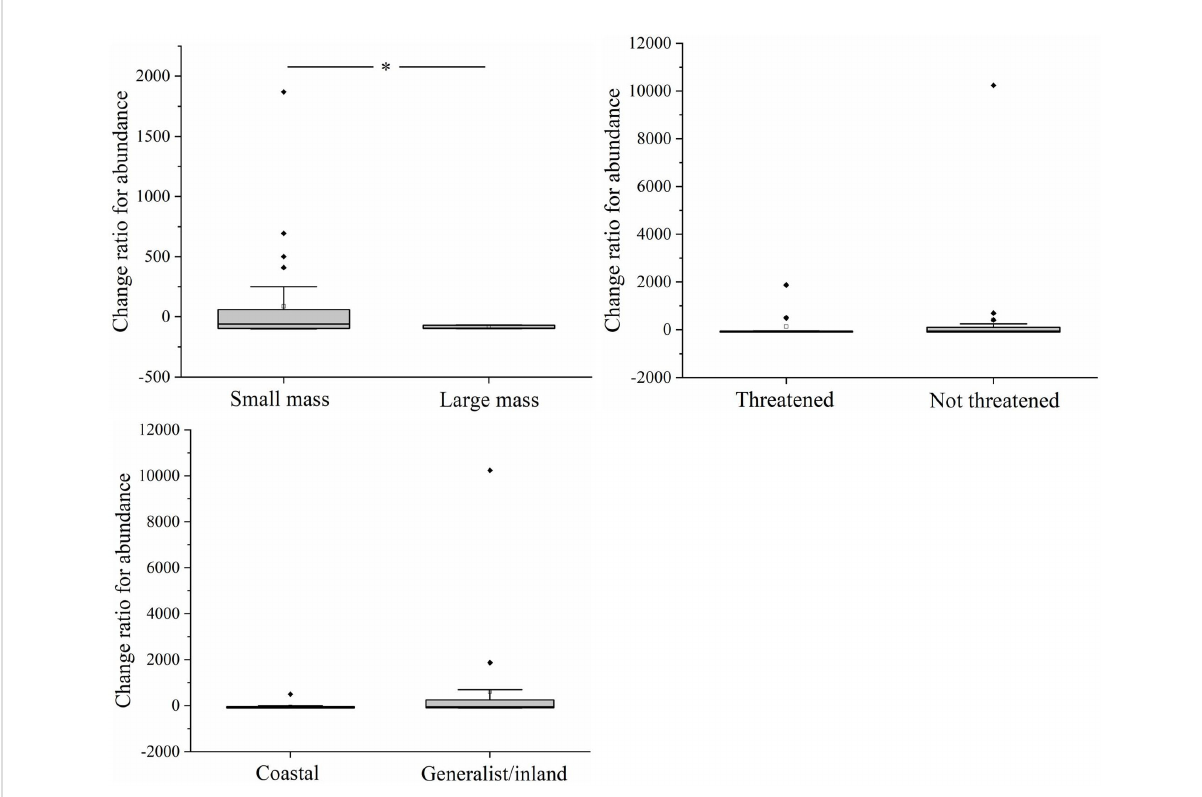
FIGURE 5 Differences in changes in the abundance of each species between functional groups in the Yellow River Delta. White squares represent mean values, horizontal bars within boxes represent median values, the upper and lower limits of boxes represent the maxima and minima, respectively, and whiskers represent 1% and 99%. Black squares represent abnormal value. *means signi fi cant at the 0.05